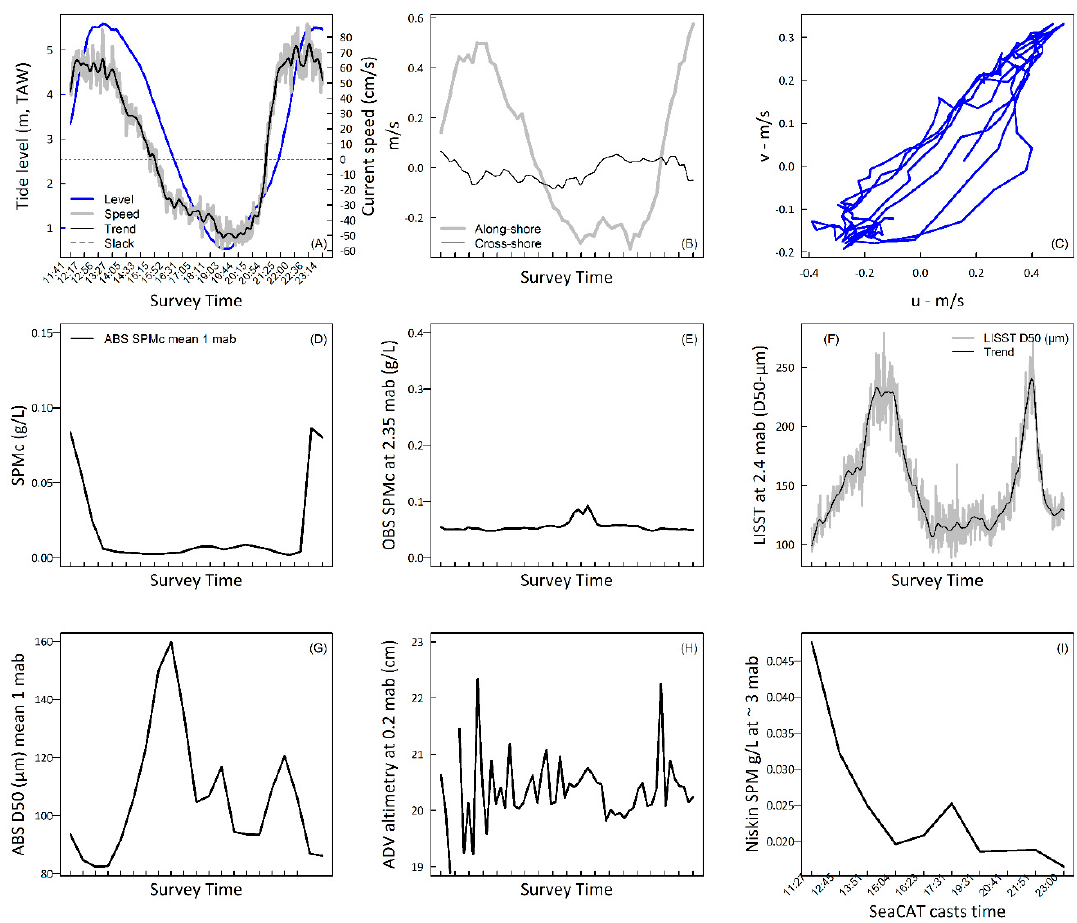
Figure 9. Synthesis of the benthic lander dataset of the Westdiep area (second experiment). ( A ) Tidal level with current speed. Slack water indicated by the horizontal dashed line. The trend of the current speed is achieved by fitting of a cubic smoothing spline function: ( B ) Current speed in along- and cross-shore directions; ( C ) Tidal ellipse for the duration of the experiment; ( D ) Vertically averaged SPMc for the 1 mab, as detected by the ABS sensor; ( E ) Same as ( D ), but detected by an OBS installed at 2.35 mab; ( F ) Median particle diameter (D50) detected by the LISST at 2.35 m; trend obtained as in ( A ); ( G ) Vertically averaged D50 as in ( D ); ( H ) Seabed altimetry from an ADV sensor at 0.2 mab; ( I ) SPM ~3 mab, obtained from the water filtrations of the CTD-installed Niskin bottle.